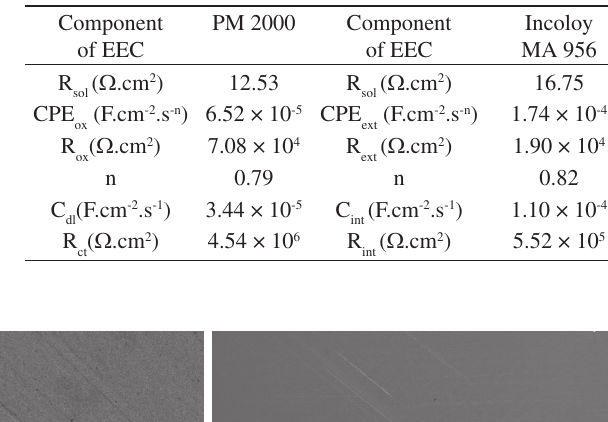
Table 3. Comparison of the values of the components of the equivalent electric circuit (EEC) associated to Figure 2b, for Incoloy MA 956 and the PM 2000 alloys in PBS solution.